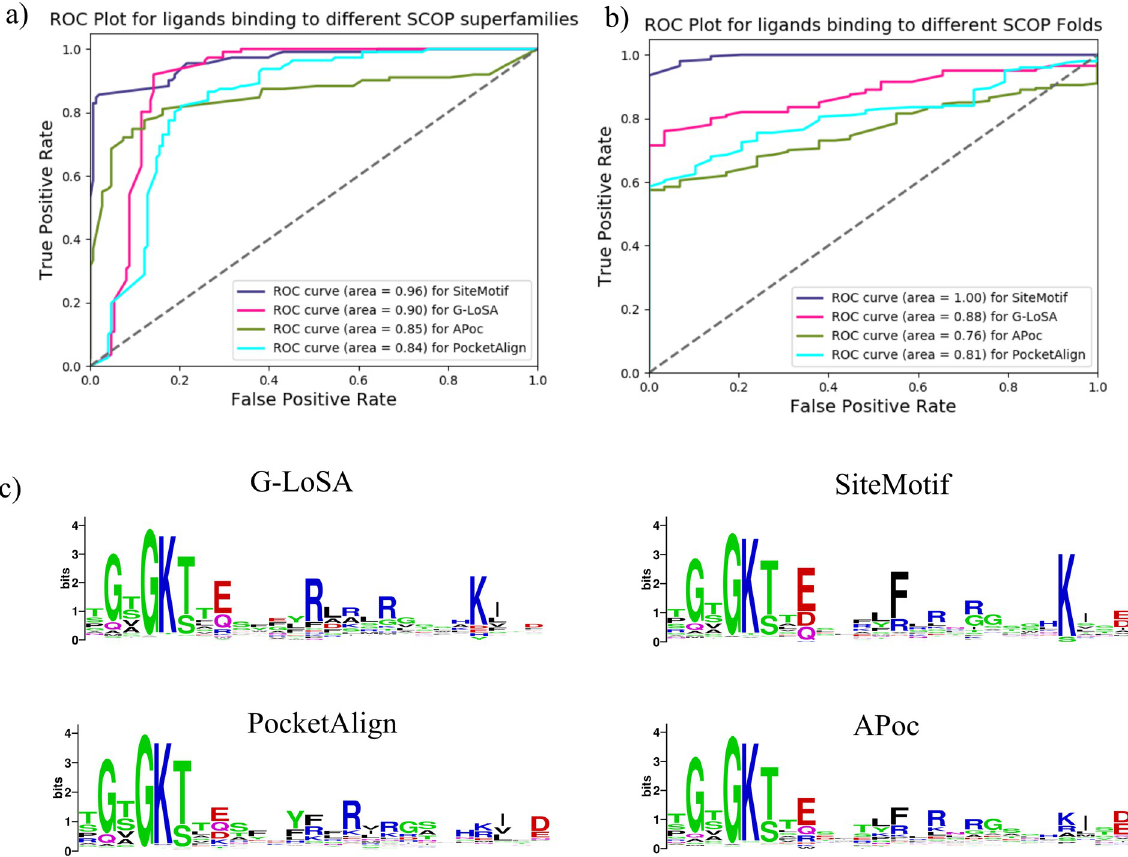
Fig 5. ROC curves of SiteMotif against widely used site alignment programmes G-LoSA, APoc and PocketAlign. The similarity score was computed by dividing the number of residues aligned by the number of residues of the smallest binding sites. A) Includes pairs of binding sites from proteins of different families but of the same SCOP fold and known to bind the same ligand. All 4 algorithms detect similarities well and the length of the alignment does not vary much. B) Includes pairs of binding sites from proteins adopting different folds but sharing structural similarity only in the local region of the binding sites. SiteMotif performs better than other methods and identifies distantly gapped structural motifs that were not detected by other methods. G-LoSA came out as the second best performing tool. C) Weblogo showing the conservation of ATP binding sites derived using different site alignment